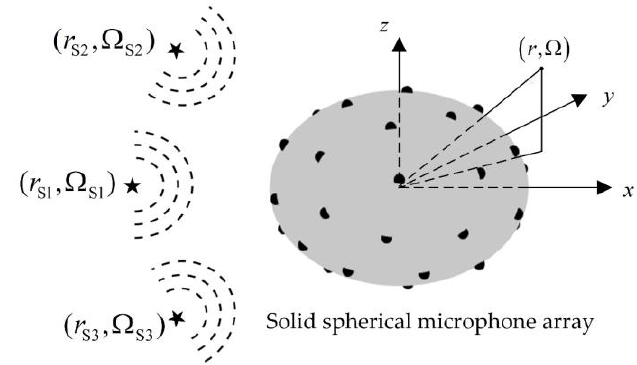
Figure 1. Sound pressure signal model of a solid spherical array.